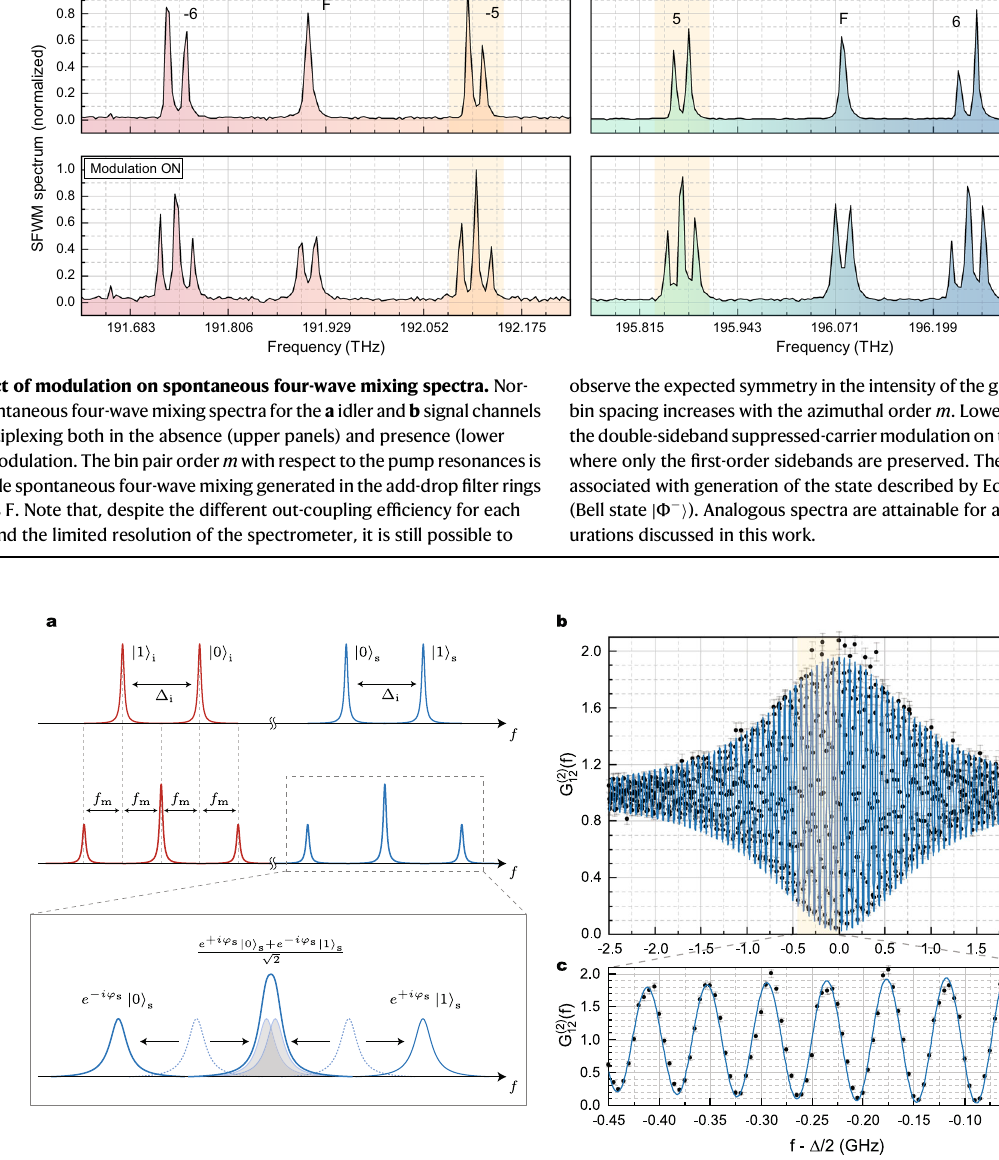
Fig.4|Frequencymixingandtwo-photoninterference.a Schematicoftheeffect of modulation on the generated idler (red) and signal (blue) frequency bins. The frequency mixing produces maps each of the signal and idler states in a super- position of three frequency components: the outermost ones are reminiscent of the probability amplitude proportional to ∣ 0 i s,i or ∣ 1 i s,i , while the “ central ” bin results in a superposition of the two. Each frequency-shifted bin also acquires a phase± φ s,i due to the modulation. The superposition of the generated bins is regulatedbythemodulationfrequency,andtheoverlapisideallymaximizedwhen